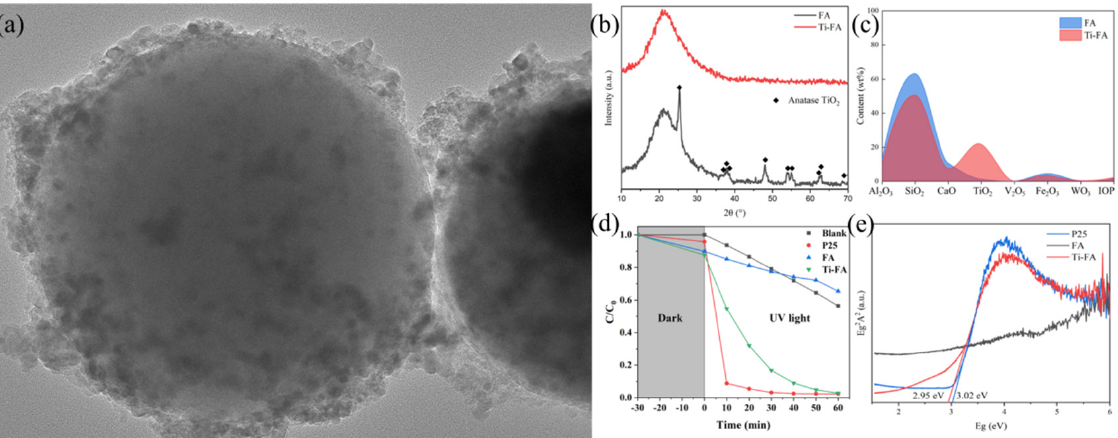
Figure 6. ( a ) Microscopic view of Ti-FA surface by TEM, ( b ) XRD pattern, ( c ) XRF test results and ( d ) UV degradation of rhodamine B catalytic performance test results; ( e ) UV-DRS test results. Reproduced with permission [74]. Copyright 2022, Elsevier.